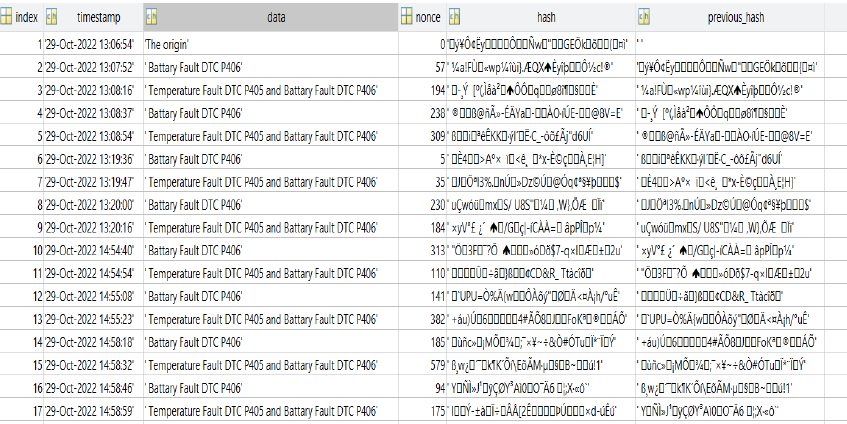
Figure A6. The code used to save data inside the Blockchain in the case of receiving valid data.